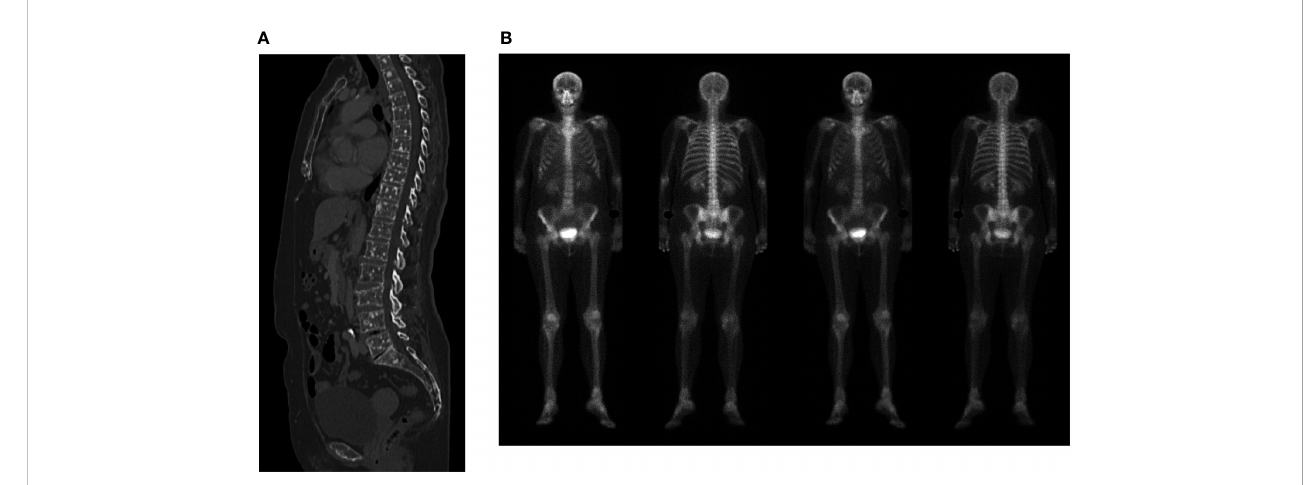
FIGURE 2 (A) Computed tomography scan showing multiple bone lesions. (B) Bone scan showing no evidence of bone